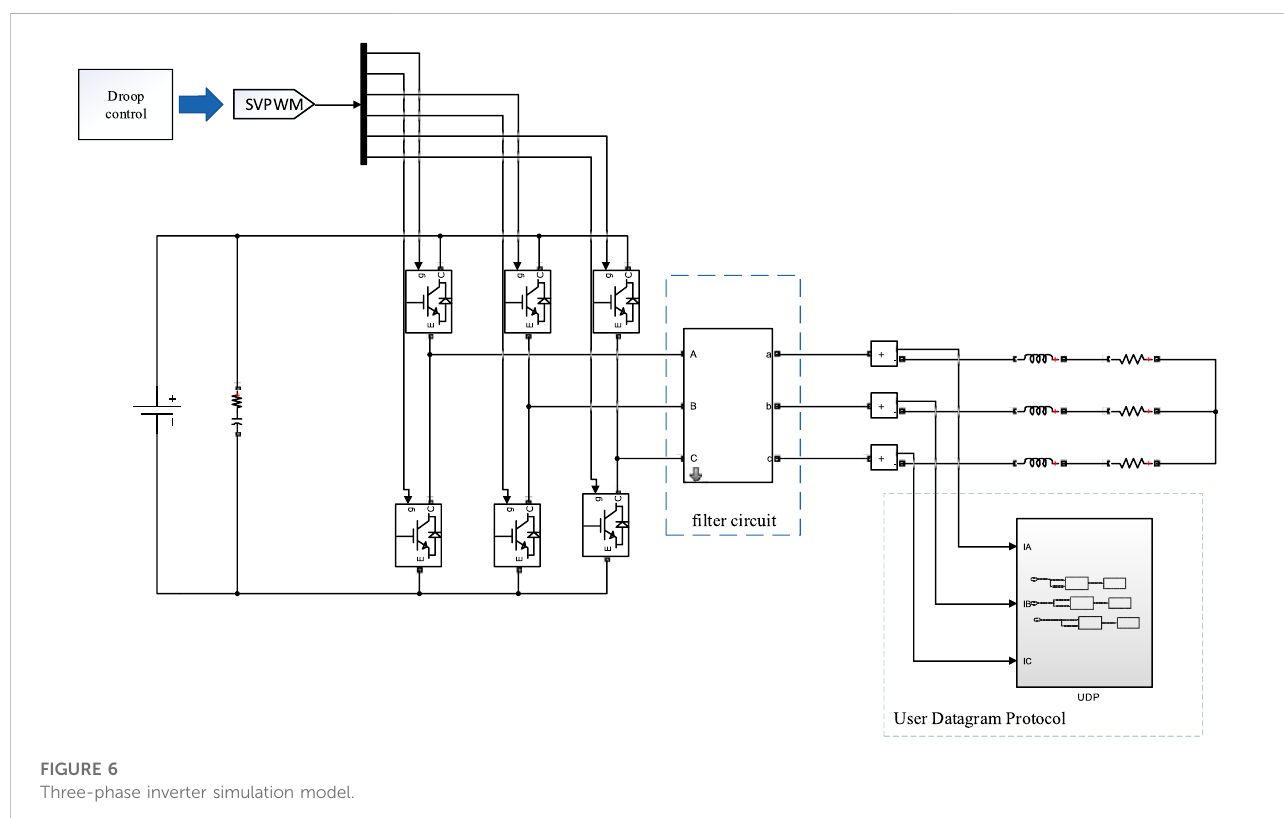
FIGURE 6 Three-phase inverter simulation model.